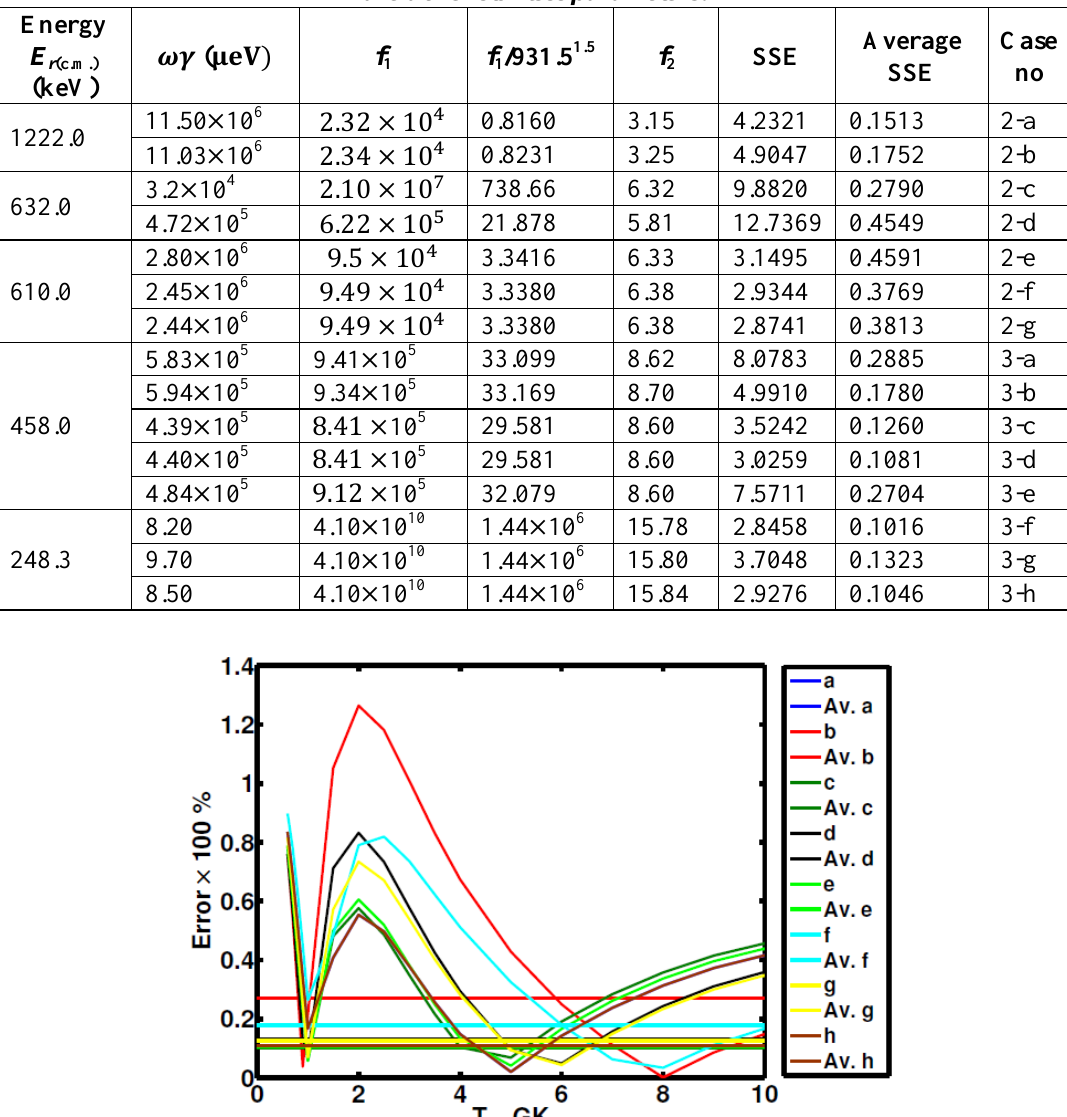
are dimensionless parameters.